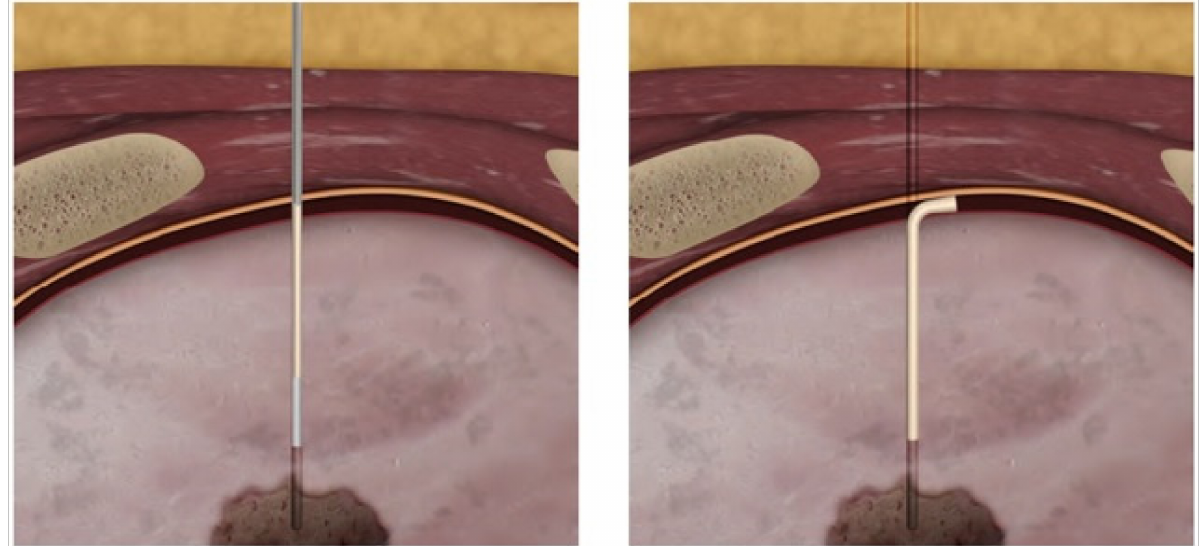
Figure 1. A cartoon slide showing the plug deployment.